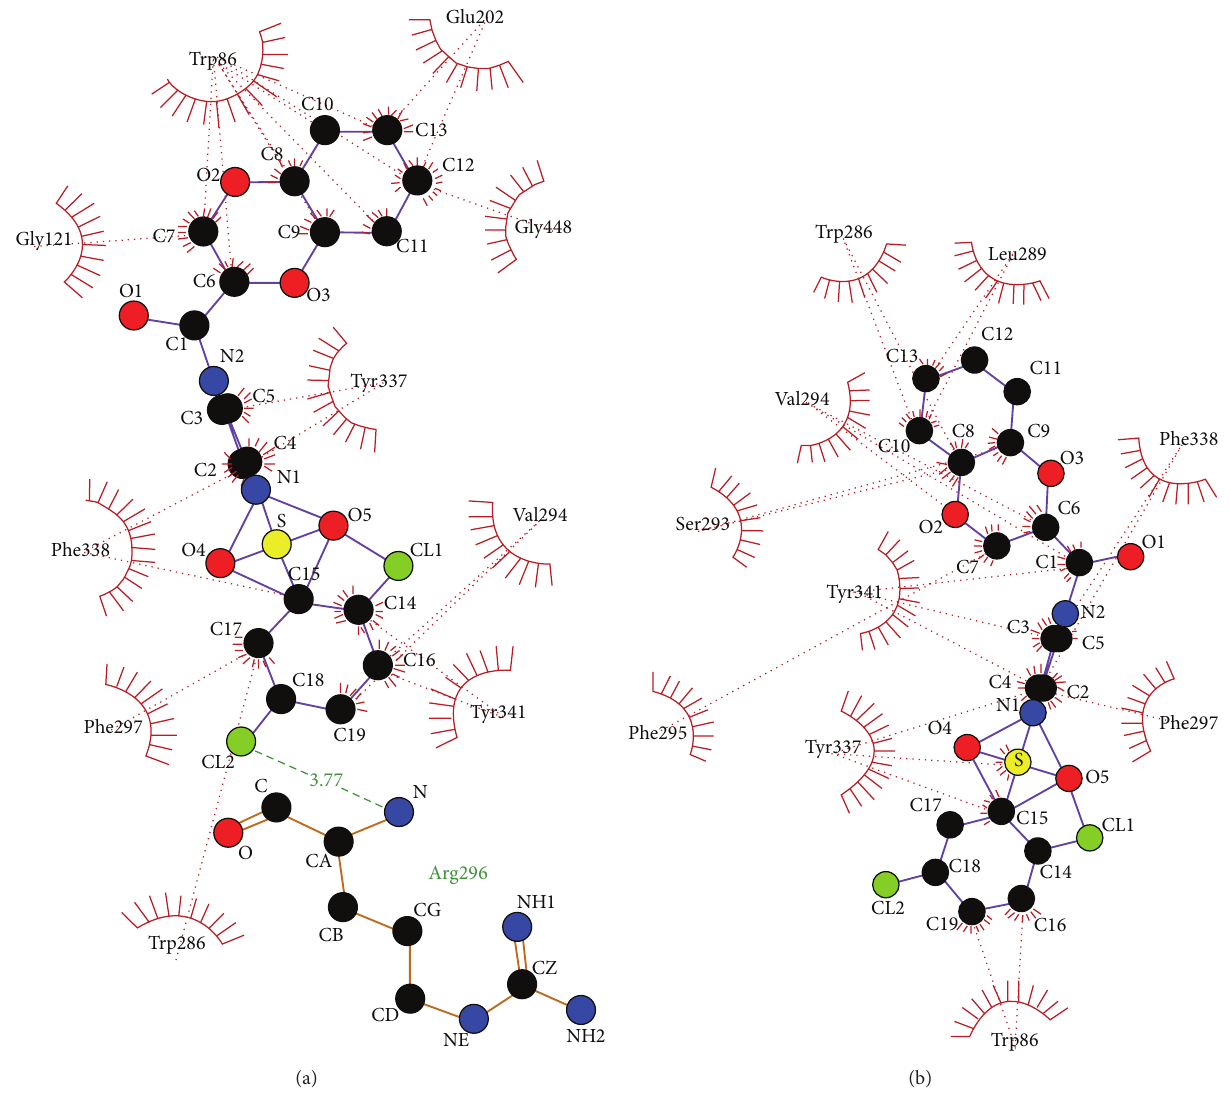
Figure 6: (a) Catalytic site docking of 4-(2,5-dichloro)-benzenesulfonyl-1-(1,4-benzodioxane-2-carbonyl) piperazine (S7). (b) Peripheral anionic site docking of 4-(2,5-dichloro)-benzenesulfonyl-1-(1,4-benzodioxane-2-carbonyl) piperazine (S7). Table 1: Details of molecular interactions in the binding site and PAS sites of docked complexes. PAS site Catalytic site Ligands